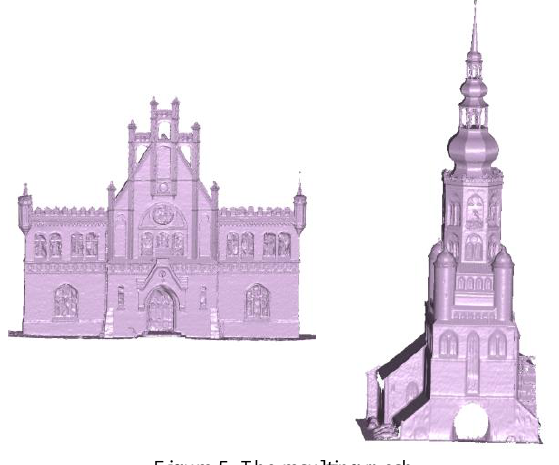
As shown in Figure 6, based on estimated values of camera parameters for acquired images, the texture can be assigned to each triangle of mesh. The images for texture mapping should be selected by user and based on illumination conditions to decrease some image distortion. On the other hand, there is no texture information in occluded area and so the quality of resulting texture is decreased in some parts of 3D